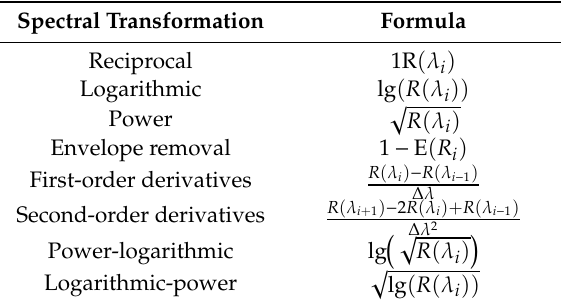
Table 2. Spectral transformation